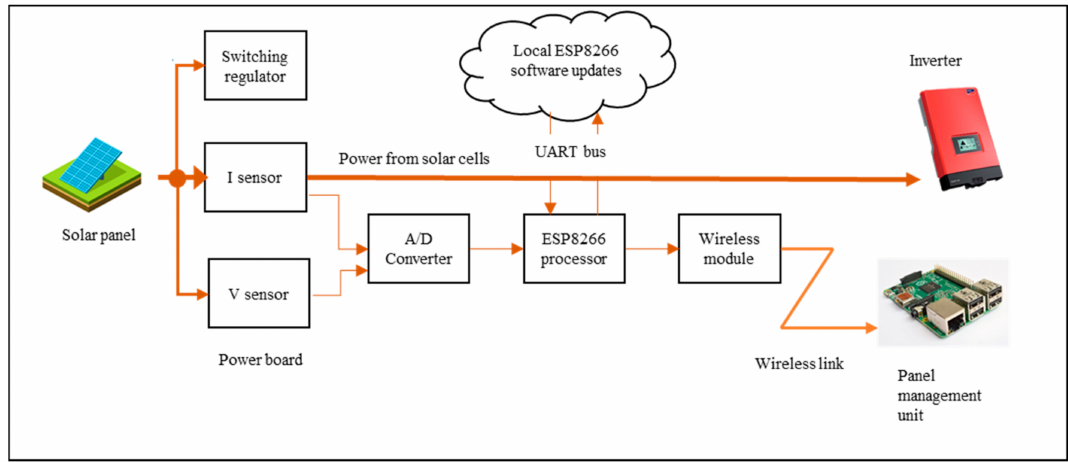
Figure 7. M500 component level